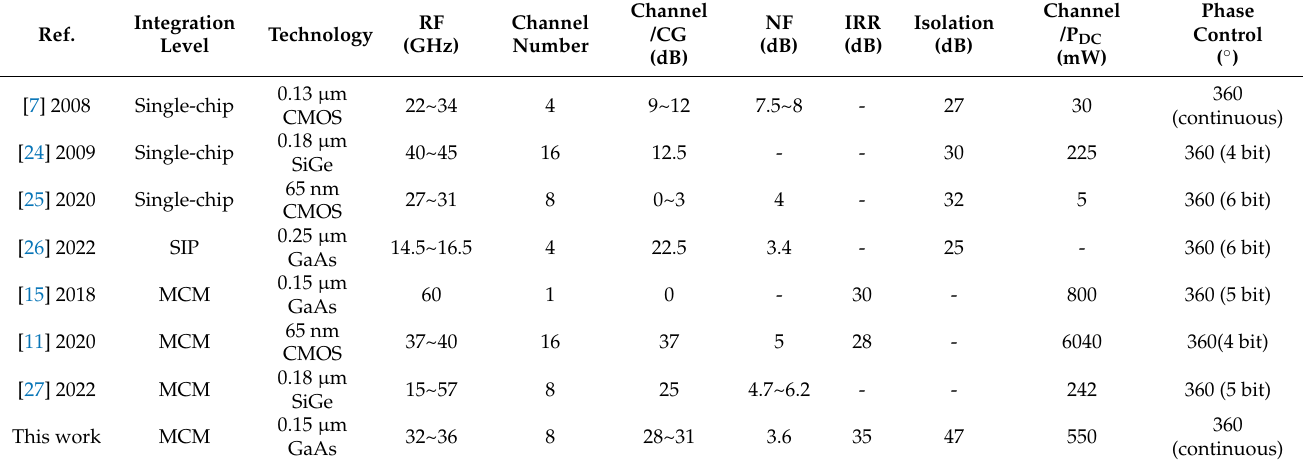
Table 3. A comparison of our model with previously published phased array receiver front end.